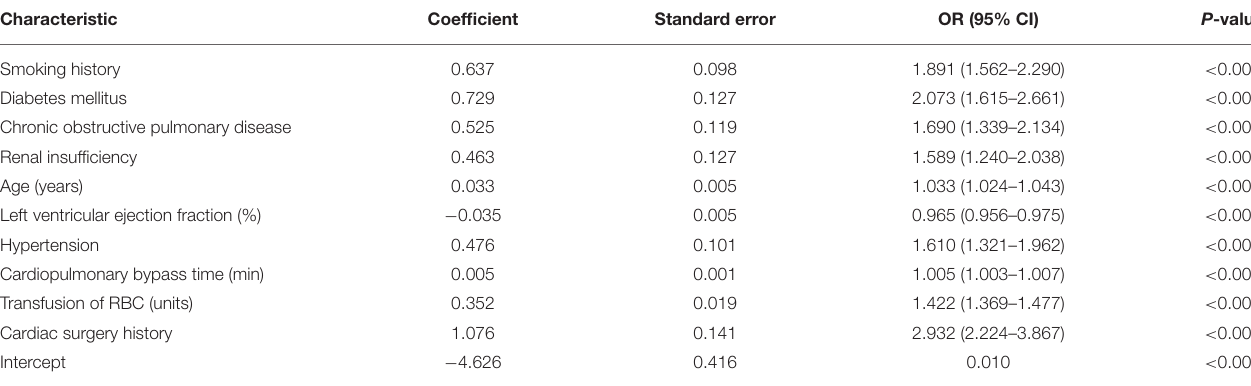
TABLE 3 | Multivariate analysis of independent risk factors for POP after elective cardiac